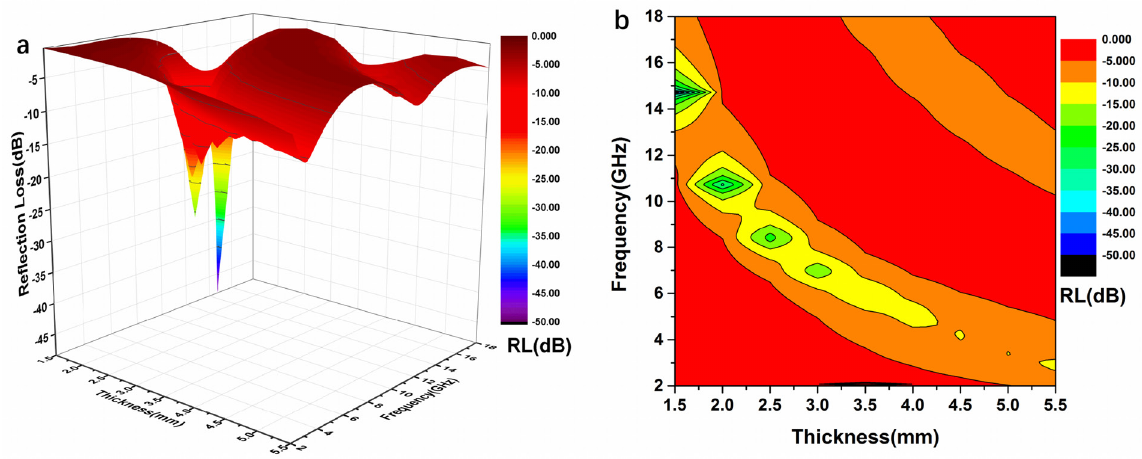
Figure 7: (a) 3D representation of RL performance of RGO/SrFe 12 O 19 nanocomposites; (b) Contours of the calculated RL values for RGO/SrFe O nanocomposites 12 19